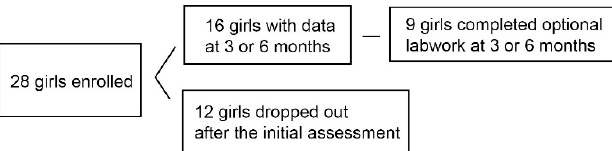
Figure 1. Subjects recruited and retained.